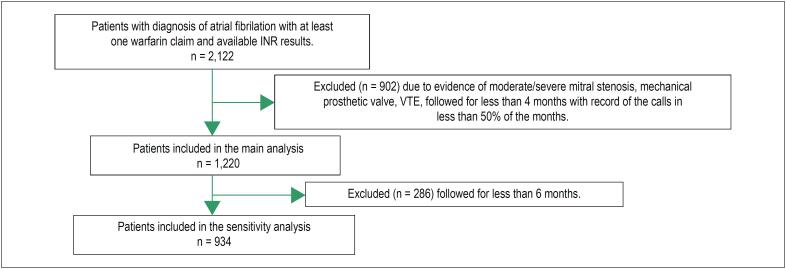
Flow chart describing inclusion and exclusion criteria.